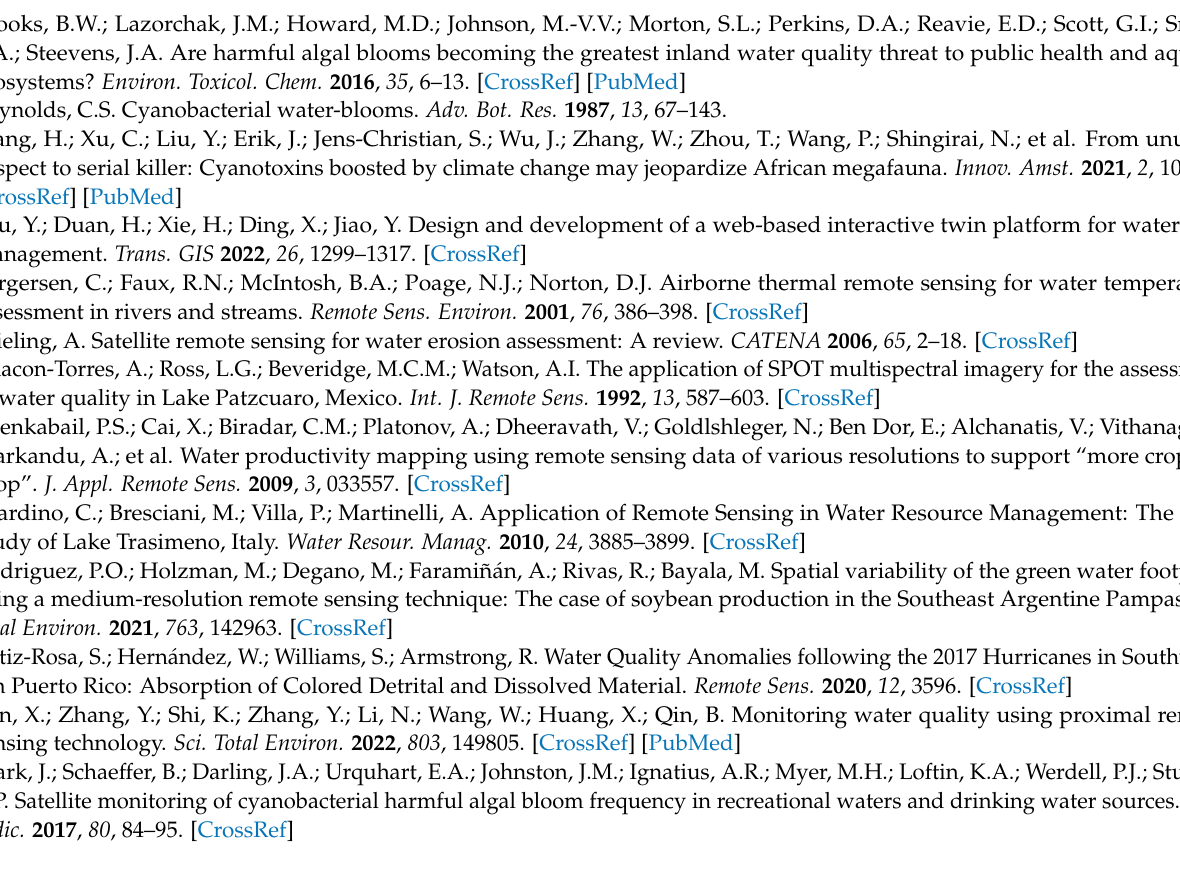
acquisition system; Figure S1: Basic principle of binocular stereo vision; Table S2: Description of the camera calibration parameters; Figure S2: Image correction; Figure S3: Disparity image